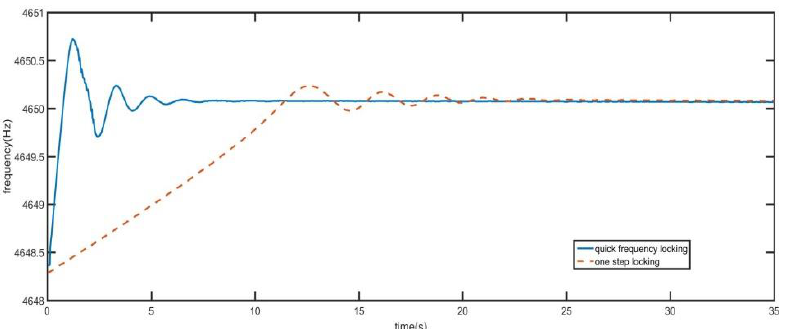
Figure 16. Comparison of two control modes when the initial frequency deviation is 1Hz.